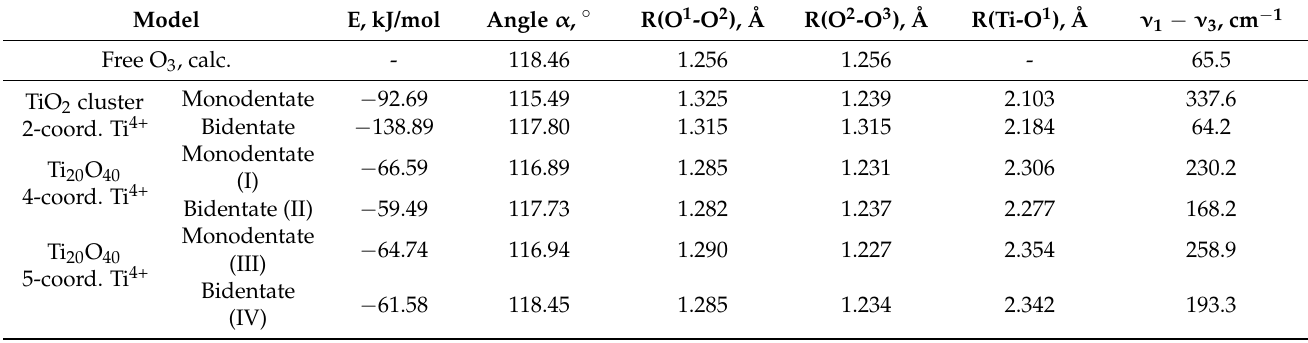
Table 1. Adsorption energy (E), geometry, and the difference in fundamental frequencies ( ν 1 − ν 3 ) of O 3 molecule bound to TiO 2 model